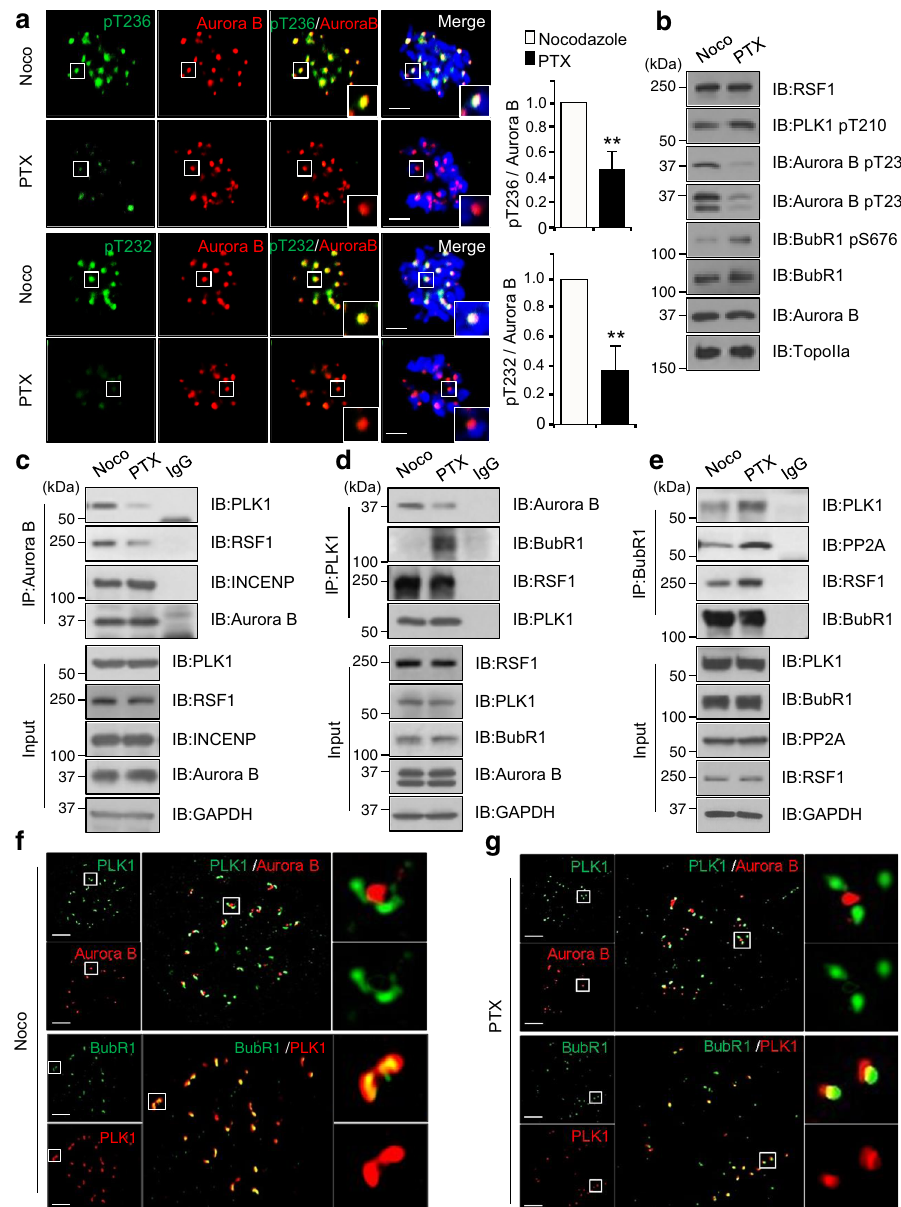
Fig. 6 Precise regulation of RSF1-PLK1 axis ensure proper kinetochore bi-orientation. a HeLa cells were treated with nocodazole or paclitaxel treated for 4 h. Mitotic cells were fi xed with 4% paraformaldehyde and stained with anti-pT236 or anti-pT232-Aurora B (green) and anti-Aurora B (red) antibodies. Nucleus was stained with DAPI (blue). The bar graph represents mean ± SEM from three independent experiments; signal intensity of Aurora B-pT232 (Noco n = 26, PTX n = 31) or pT236 (Noco n = 23, PTX n = 36) at the kinetochores. ** p < 0.005 vs. Nocodazole by two-sided unpaired Student ’ s t -test. Scale bar, 5 μ m. b Immunoblotting of chromatin fractions in nocodazole- or paclitaxel-treated HeLa cells using indicated antibodies. c Nocodazole- or paclitaxel-treated HeLa cells were immunoprecipitated using anti-Aurora B antibodies. The inputs and immunoprecipitants were analyzed by western blotting. d Mitotic extracts from nocodazole- or paclitaxel-treated HeLa cells were immunoprecipitated using anti-PLK1 antibody. e Nocodazole- or paclitaxel-treated HeLa cells were immunoprecipitated using anti-BubR1 antibody and immunoprecipitated samples were immunoblotted with PP2A antibodies. f Super-resolution confocal single slice images of PLK1 in prometaphase cells. Nocodazole-treated HeLa cells were fi xed with 4% paraformaldehyde and stained with indicated antibodies. Scale bars, 5 μ m. g Super-resolution confocal images of PLK1 in paclitaxel-treated prometaphase cells. Floating mitotic cells were stained with indicated antibodies. Scale bars, 5 μ m. Data of b – e are representative of three independent experiments. Source data are provided as a Source Data fi RSF1 spots were overlaid with BubR1 in paclitaxel-arrested cells, reduced the RSF1 binding (Fig. 7d). In contrast, RSF1 bound whereas treatment with ZM447439 suppressed the redistribution BubR1 better when the H3 S28D was expressed, suggesting re- of RSF1 to KTs (Fig. 7c), showing the remaining RSF1 at the localization of RSF1 to KTs. Likewise, RSF1 remained on the centromeres. Next, we generated the histone H3 S28A and S28D centromeres in cells expressing histone H3 S28A, whereas it mutants, and co-immunoprecipitation assay revealed that the moved to KTs in cells introduced with histone H3 S28D (Fig. 7e) phosphorylation mimetic mutant of H3 S28D signi fi cantly in immuno fl uorescence staining analysis. Together, the data